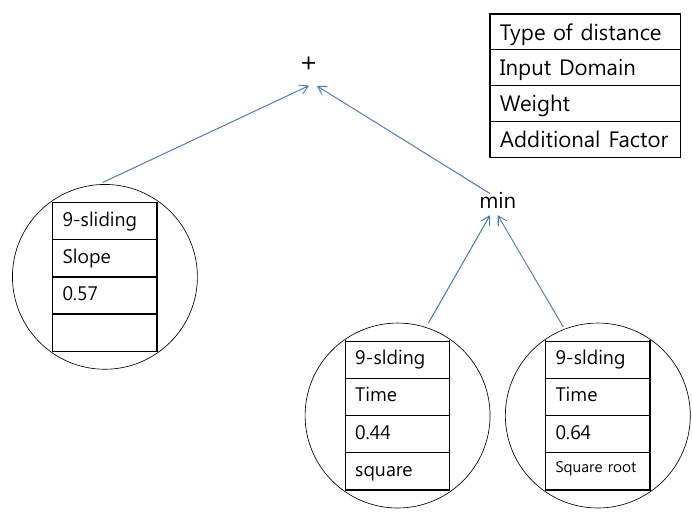
Figure 17. Proposed tree for the northern region using the data of expert #1.